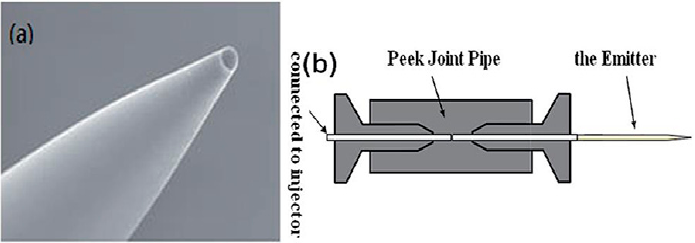
Figure 6. Process of sensor preparation by drop coating method [56].